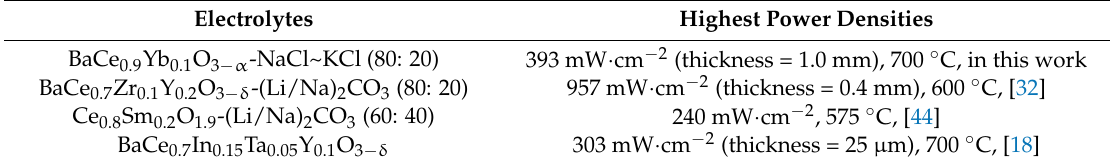
Table 1. The highest power densities of BaCe 0.9 Yb 0.1 O 3 − α -NaCl~KCl and similar electrolytes in the literature.